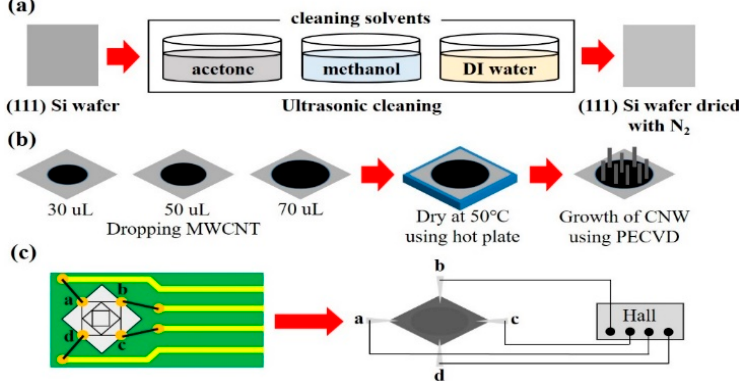
Figure 1. Schematic of experiments: ( a ) cleaning of Si wafer substrate; ( b ) synthesis of CNW (carbon nanowall) on MWCNT-based buffer layer; ( c ) measurement of electrical properties of samples.